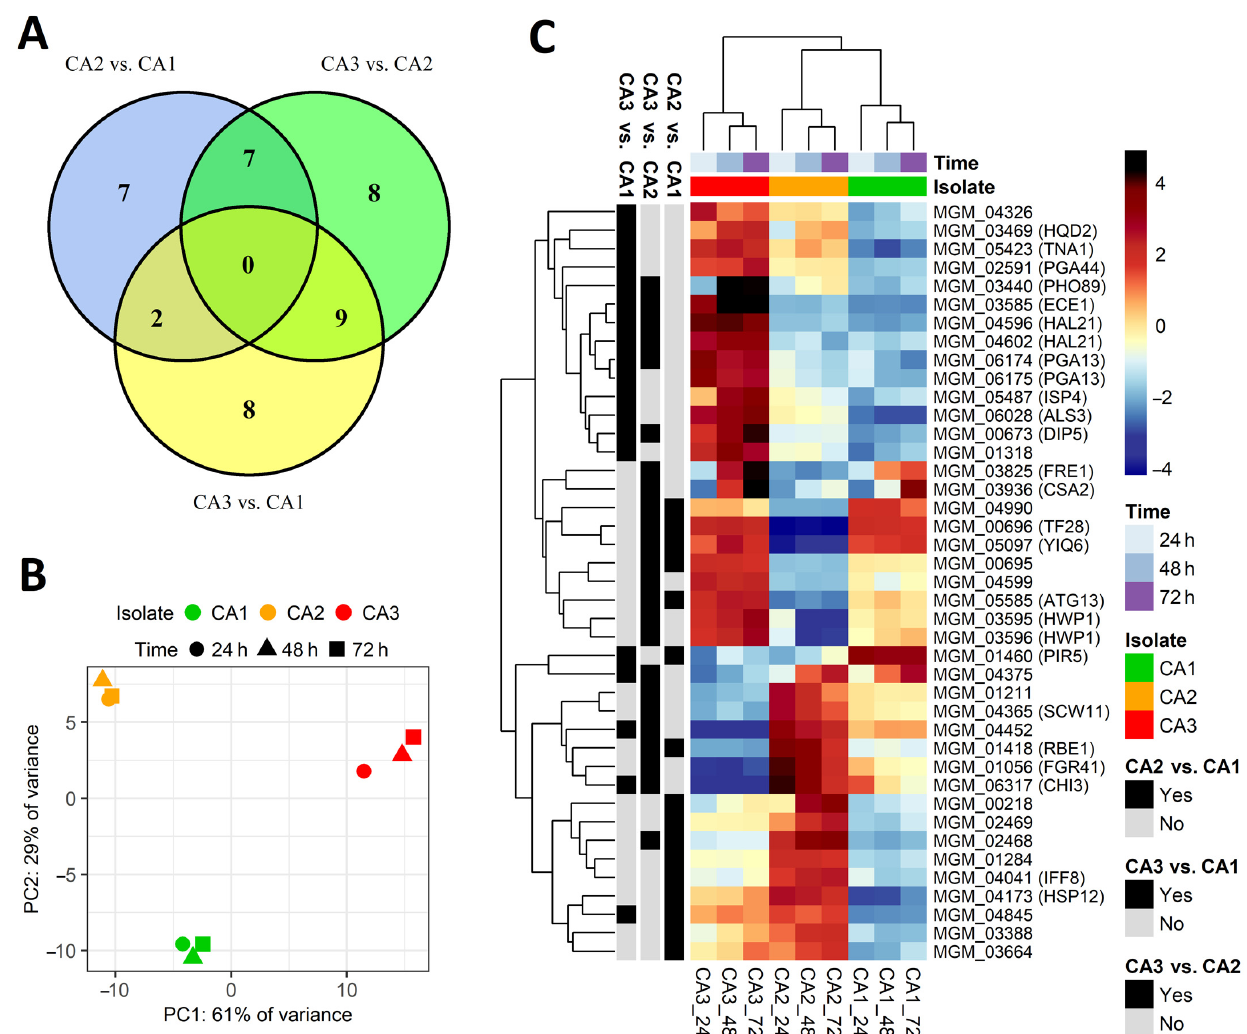
Figure 3. Differential expression of genes selected from CA2 vs. CA1, CA3 vs. CA1, and CA3 vs. CA2 comparisons. ( A ) Venn diagram showing intersections between groups of genes selected from the performed comparisons. The non-overlapping numbers denote the genes that were unique for each isolate, while overlapping numbers represent mutual differentially expressed genes. There were no genes common for all three comparisons. ( B ) PCA plot for the expression of selected genes. ( C ) Heatmap illustrating the expression of selected genes in the studied samples. Hierarchical clustering was performed using the average method applied to Canberra distances. Table 1. Differential expression characteristics of genes in Candida albicans isolates (CA1, CA2, CA3). Gene ID 1